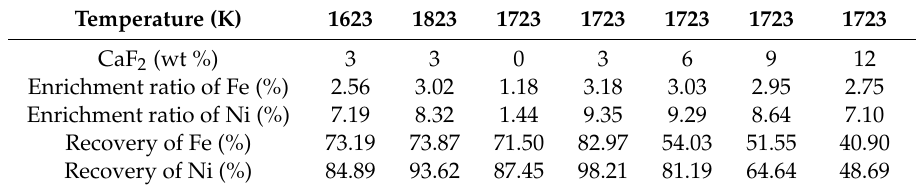
Table 5. Enrichment ratio of Fe and Ni with di ff erent dosages of CaF 2 at di ff erent temperature and Recovery of Fe and Ni during the vacuum carbothermal reduction–magnetic separation process. Temperature (K)